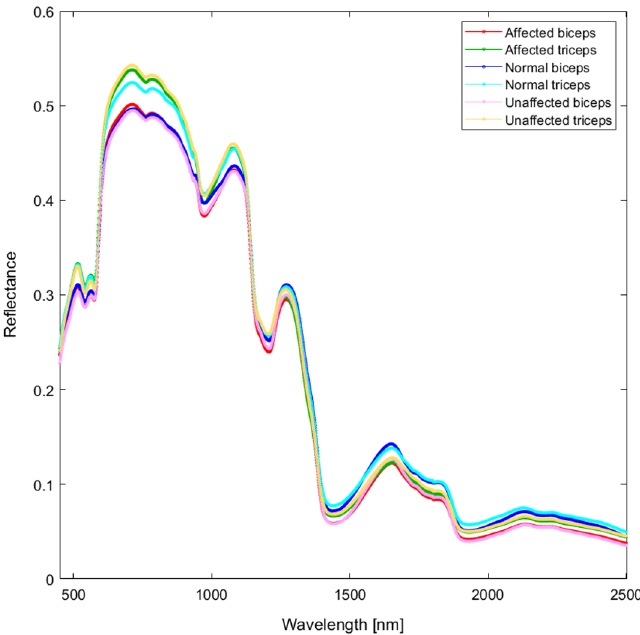
Figure 1. Average reflectance spectra of normal biceps, affected biceps, unaffected biceps, normal triceps, affected triceps, and unaffected